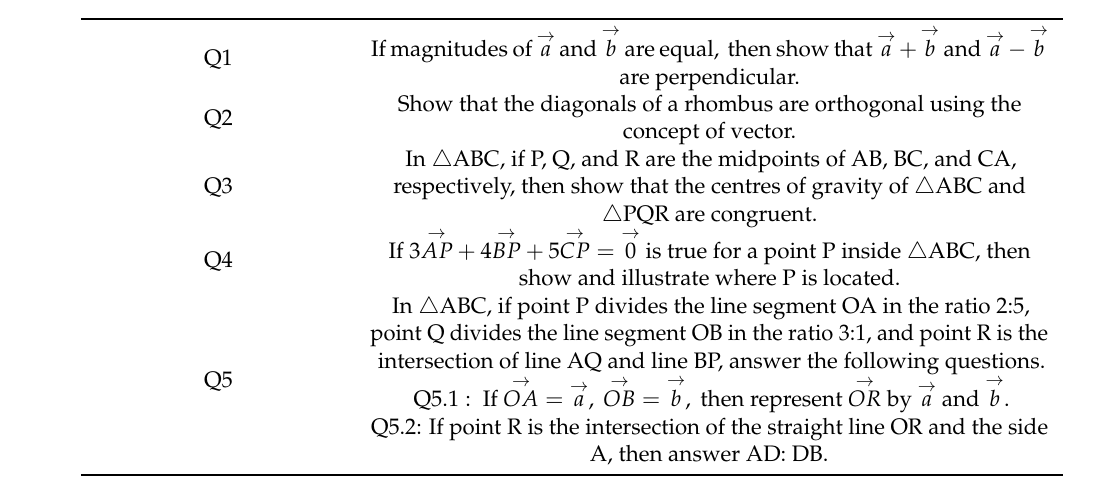
Table 2. Vector problems in this